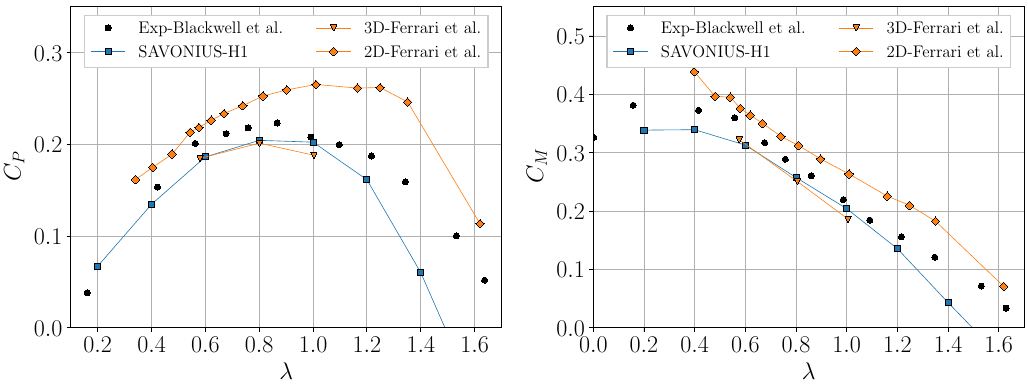
Figure 7. Experimental and numerical values of C P ( left ) and C M ( right ) as a function of the TSR ( λ ) for a straight blade turbine